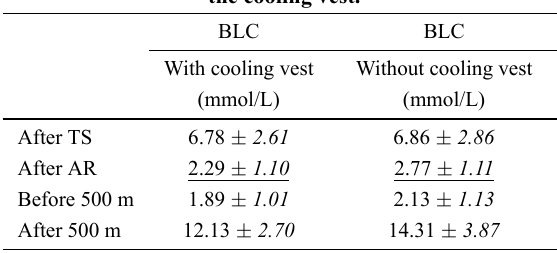
Table 2. BLC values during the protocols with and without the cooling vest.